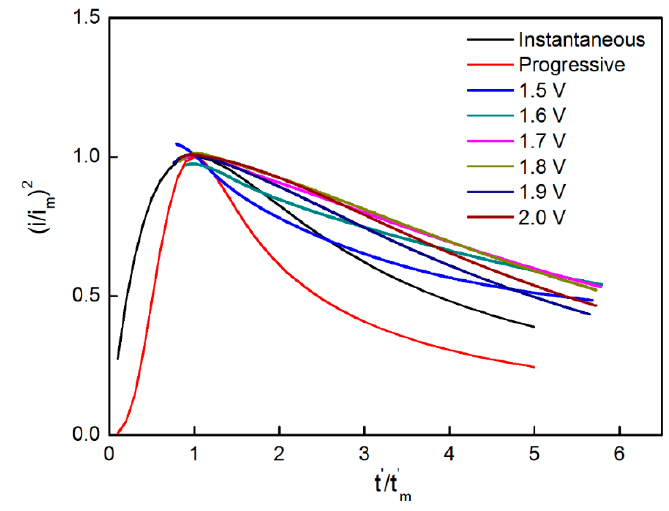
Figure 7. ( i / i m ) 2 – t’ / t’ m relationship when the potential was changed from 1.5 V to 2.0 V.